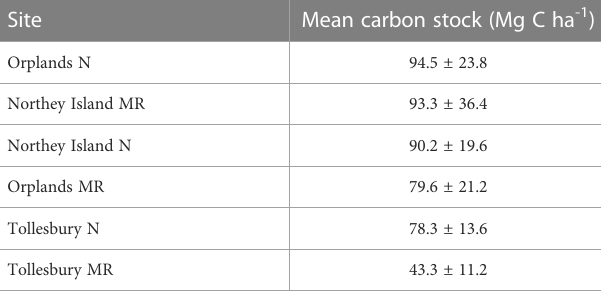
TABLE 2 Mean carbon stock (Mg C ha -1 ) in the top 30 cm of saltmarsh soil at managed realigned (MR) and natural (N) sites ± standard deviation.